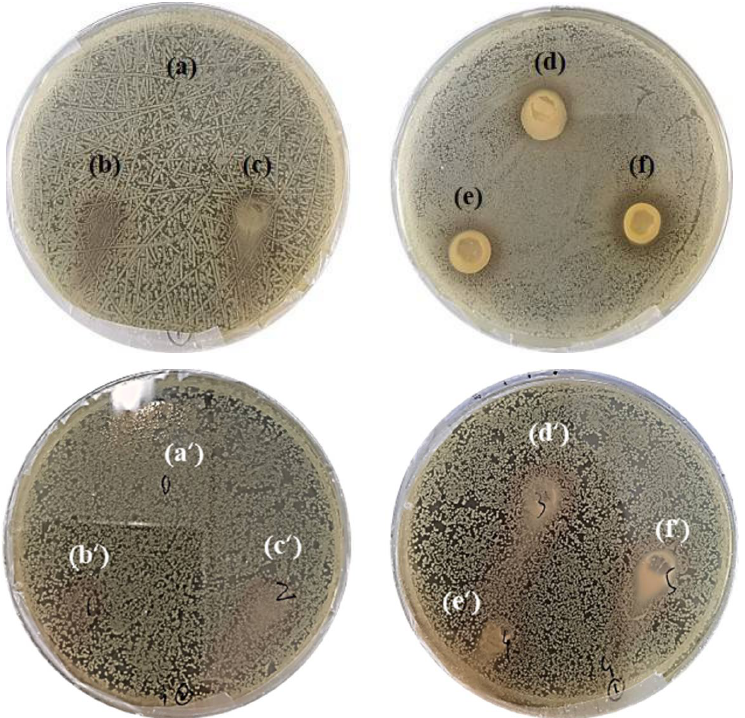
Figure 10. Antimicrobial effect against E. coil, ( a ) SA-TA 0, ( b ) SA-TA 1, ( c ) SA-TA 2, ( d ) SA-TA 3, ( e ) SA-TA 4, ( f ) SA-TA 5; and S. aureus, ( a’ ) SA-TA 0, ( b’ ) SA-TA 1, ( c’ ) SA-TA 2, ( d’ ) SA-TA 3, ( e’ ) SA-TA 4, ( f’ ) SA-TA 5.